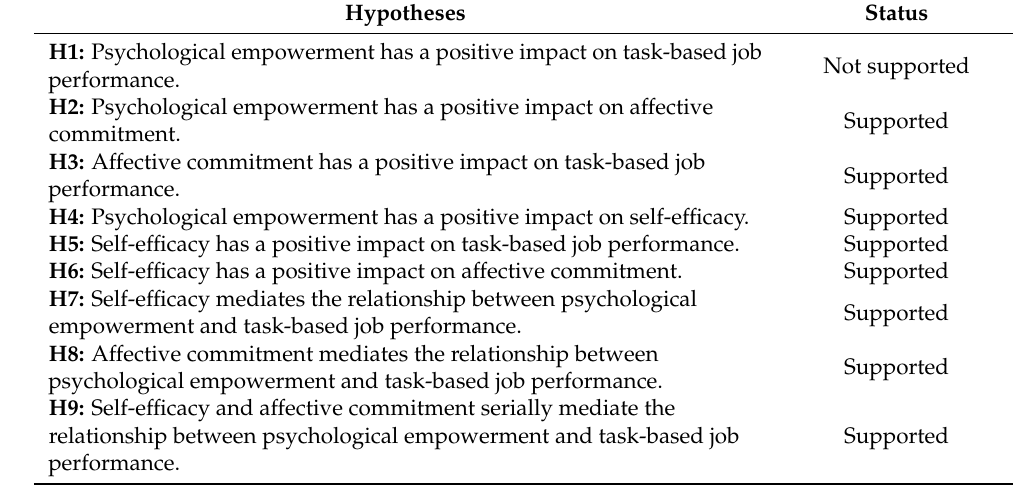
Table 6. Presentation of the null hypotheses accepted and rejected following SEM